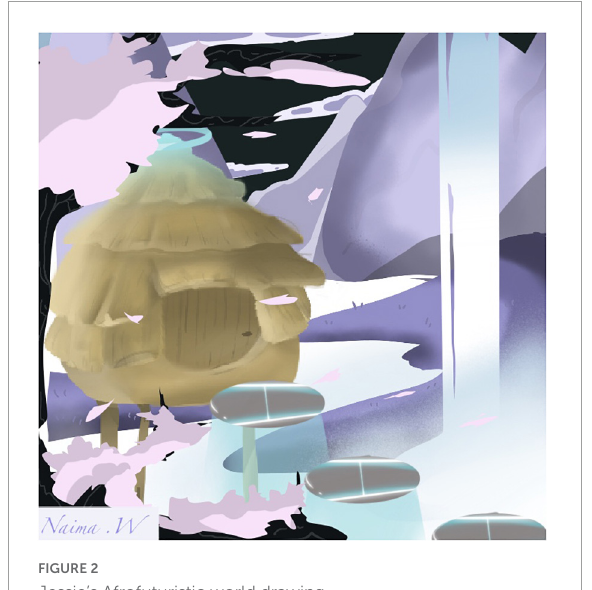
FIGURE2 Jessie’s Afrofuturistic world